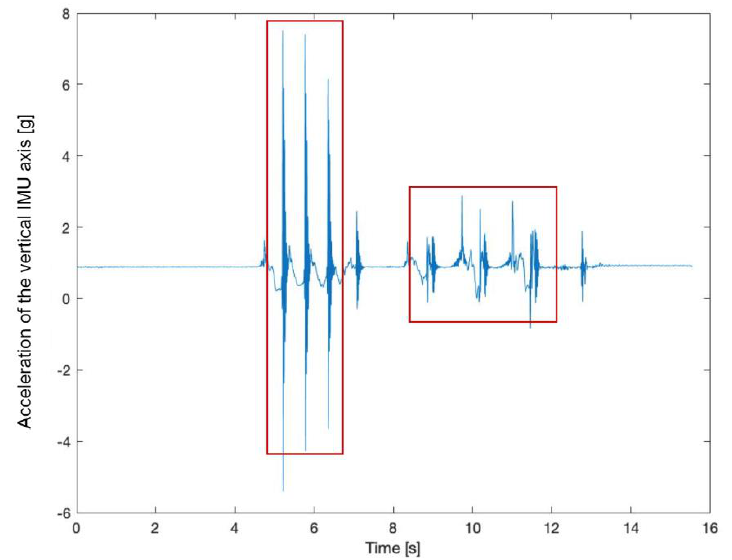
Figure 3. Sample vertical ( z -axis) raw accelerometer readings during a test. The first three spikes correspond to the synchronization signal and the following data refer to gait events. Table 1. Statistical and frequency-domain